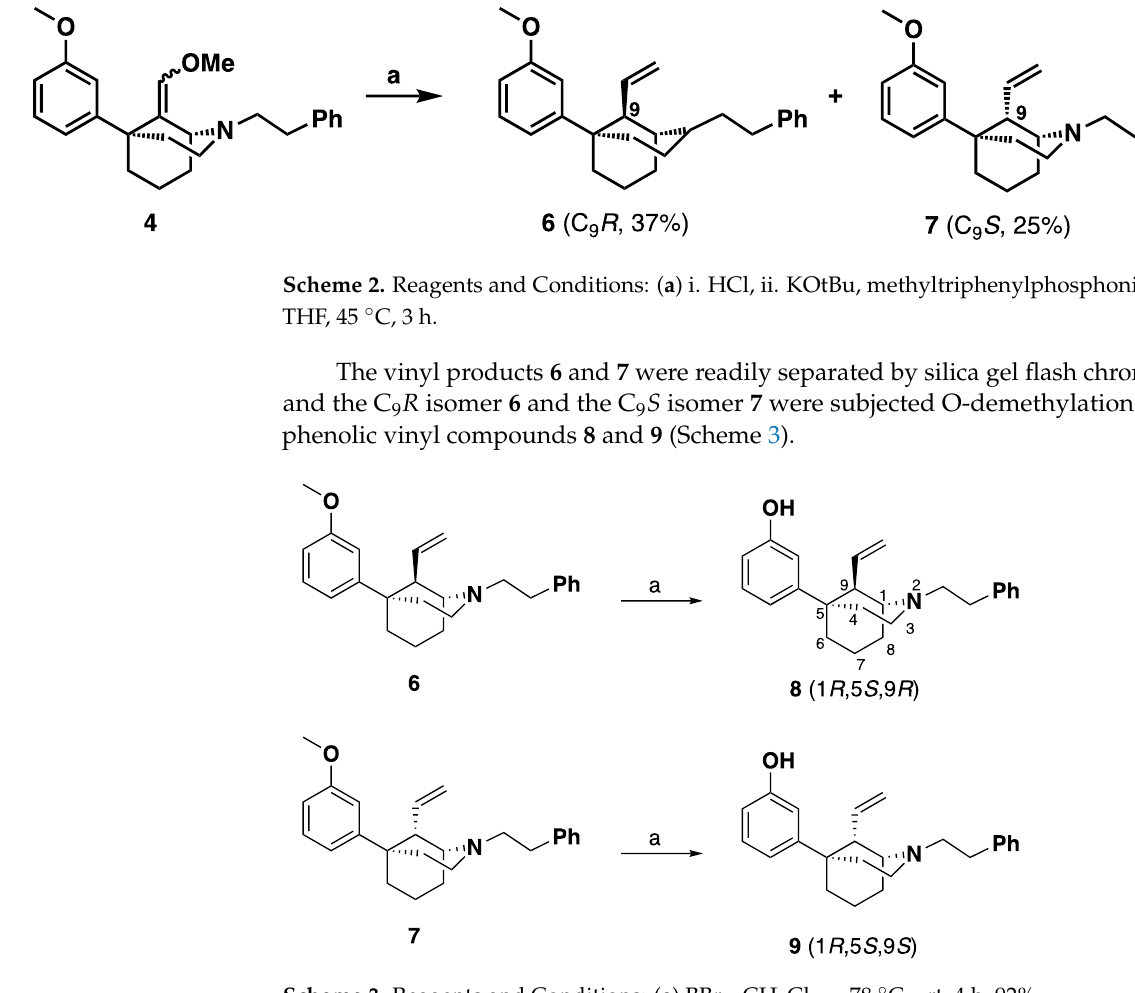
Figure 1. X-ray crystal structure of 8 (3-((1 R ,5 S ,9 R )-2-phenethyl-9-vinyl-2-azabicyclo [3.3.1] nonan-